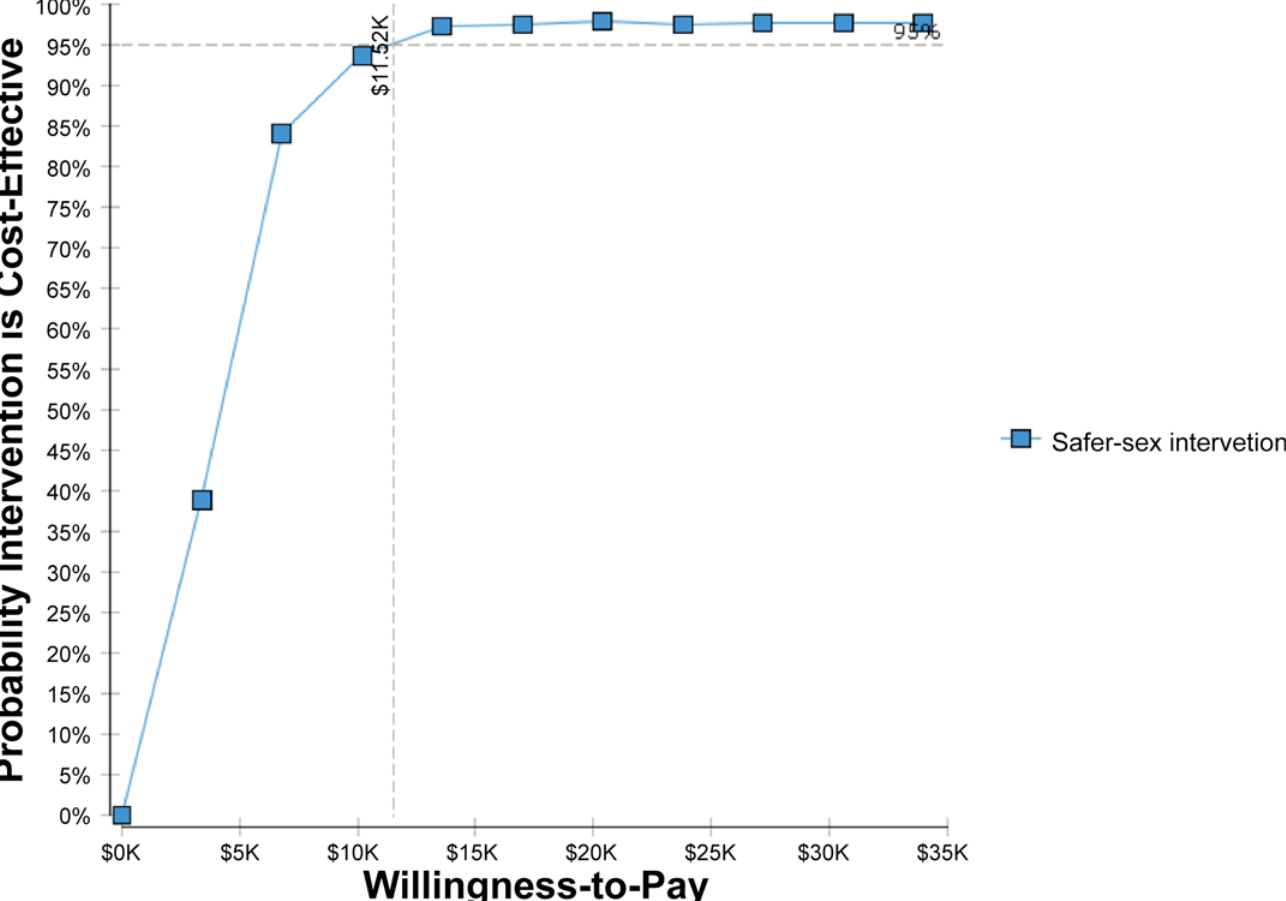
Fig 4. Cost-effectiveness acceptability curve for the combined interactive safer sex and didactic safer injection components of the Mujer Mas Segura intervention in